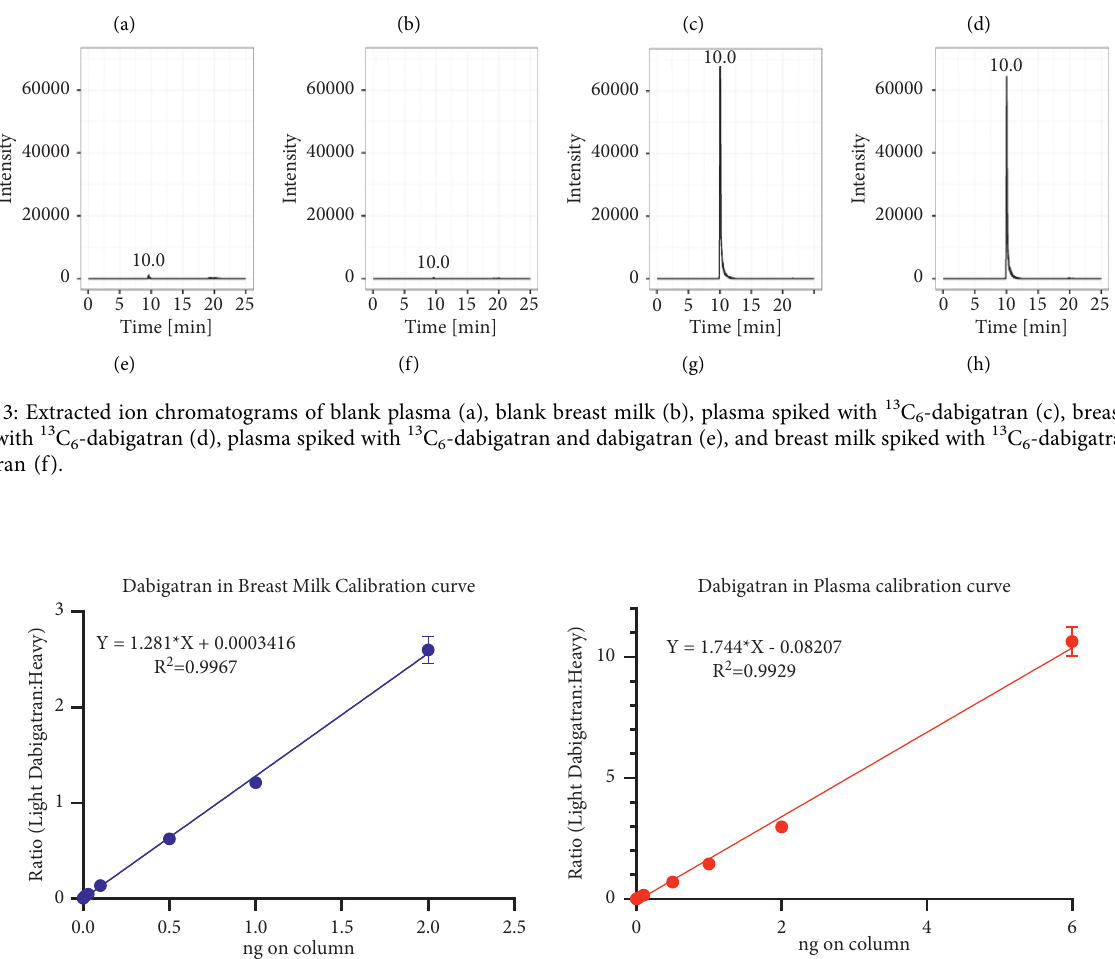
Figure 4: Calibration curves for dabigatran in plasma (concentration range: 0.0005ng–6ng) (a) and breast milk (concentration range: 0.0005–2ng)